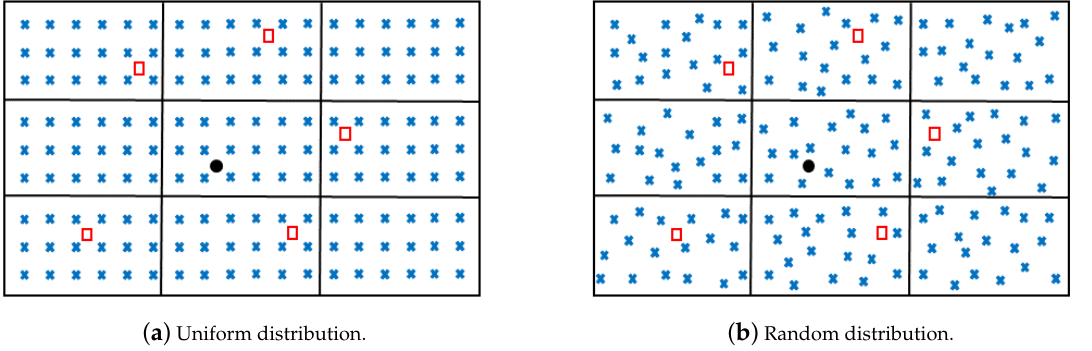
Figure 1. Illustration of fingerprinting configuration: × designates reference positions, (cid:3) WiFi access points, and • a mobile